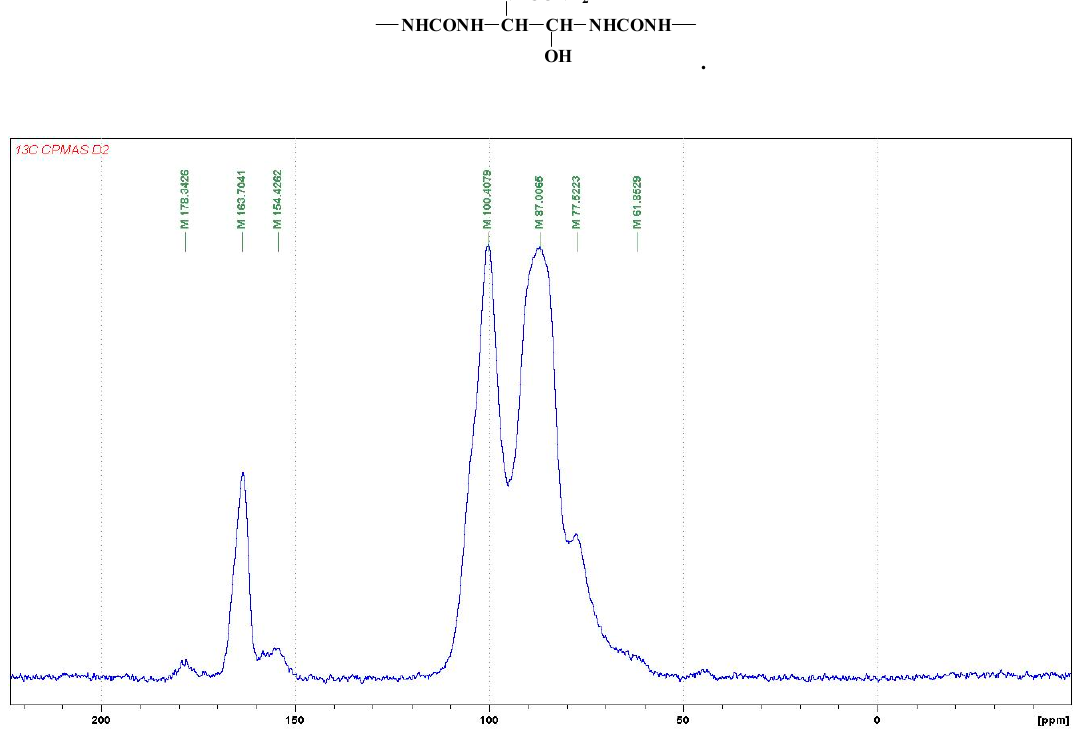
Figure 5. 13 C NMR spectrum of UG resin.